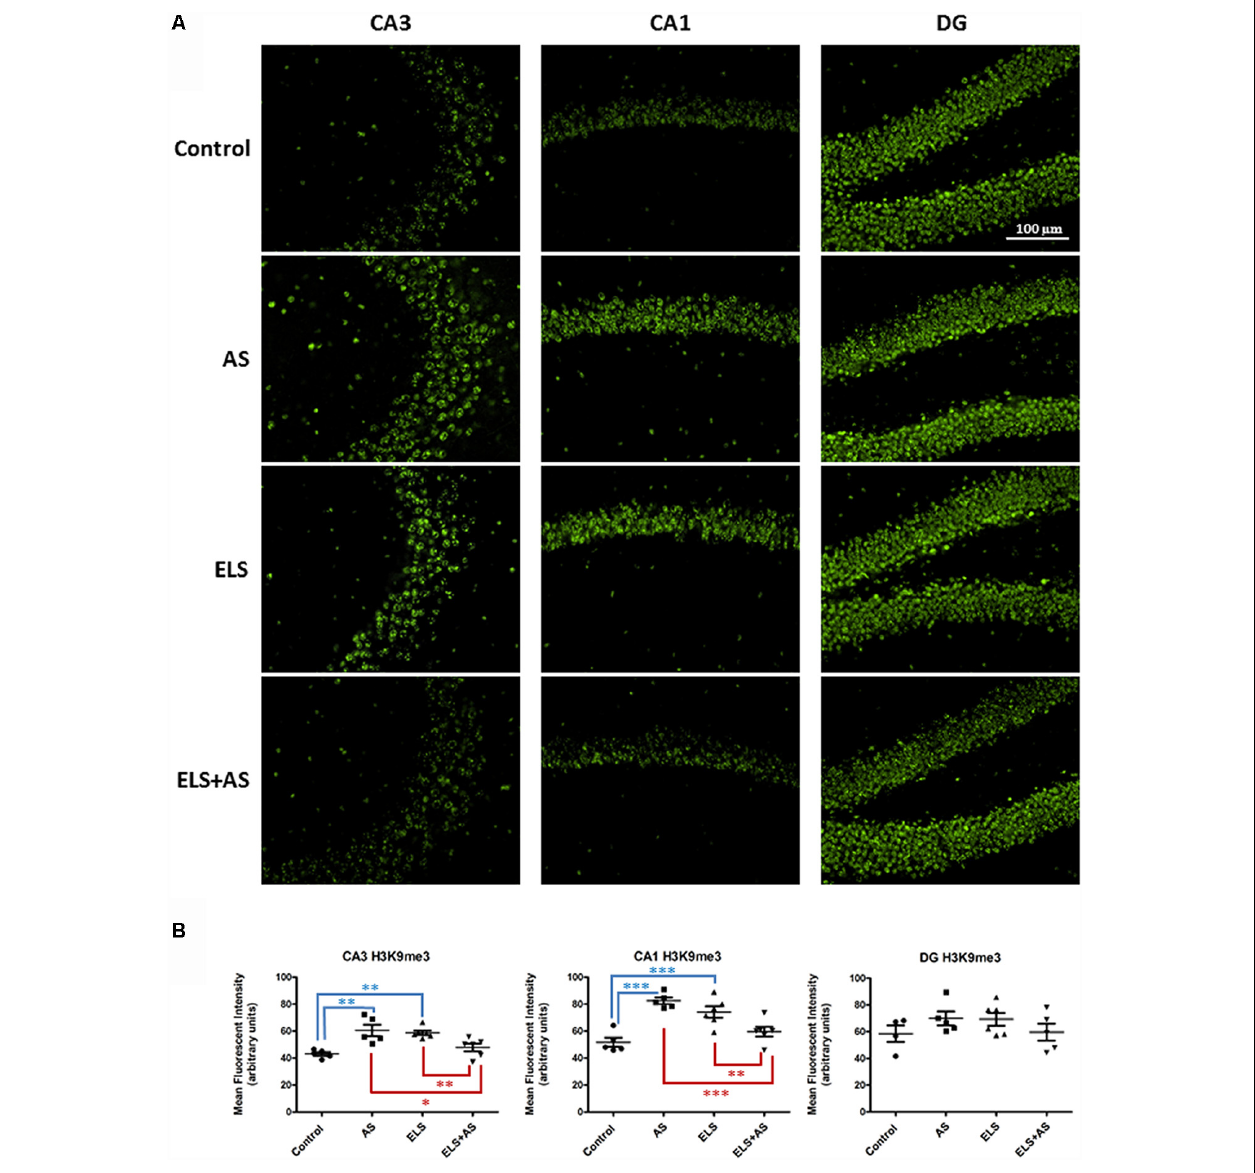
FIGURE 2 | Effects of AS and ELS on histone H3 lysine 9 tri-methylation (H3K9me3) levels in the hippocampus. (A) Immunofluorescence at 20 × magnification was used to detect H3K9me3 in CA1, CA3, and dentate gyrus (DG) regions of the dorsal hippocampus. Compared to unstressed controls, ELS and stressed controls exhibit an increase in H3K9me3 in both CA3 and CA1 regions. ELS mice subjected to AS show a reduction in H3K9me3 expression when compared to unstressed ELS mice and stressed controls in CA1 and CA3. AS does not induce differential H3K9me3 expression in control and ELS mice in the DG. Scale bar = 100 µ m. (B) Scatter plots show quantification of H3K9me3 immunoreactivity ( n = 5–6). ∗ p < 0.05, ∗ p < 0.01, ∗∗∗ p < 0.001. ELS, early life stress; AS, acute stress. Control: n = 5, AS: n = 5, ELS: n = 6, ELS + AS: n = 6